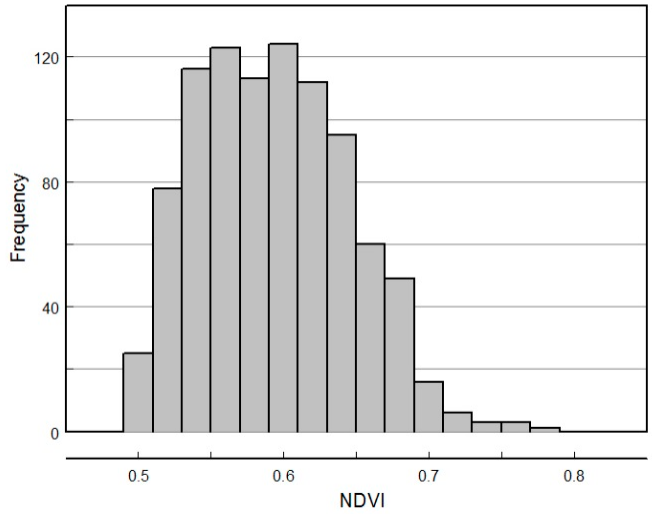
Figure 6. Frequency distribution of mean NDVI on dairy farms in the Goulburn-Murray Irrigation District in summer 2015 – 2016.